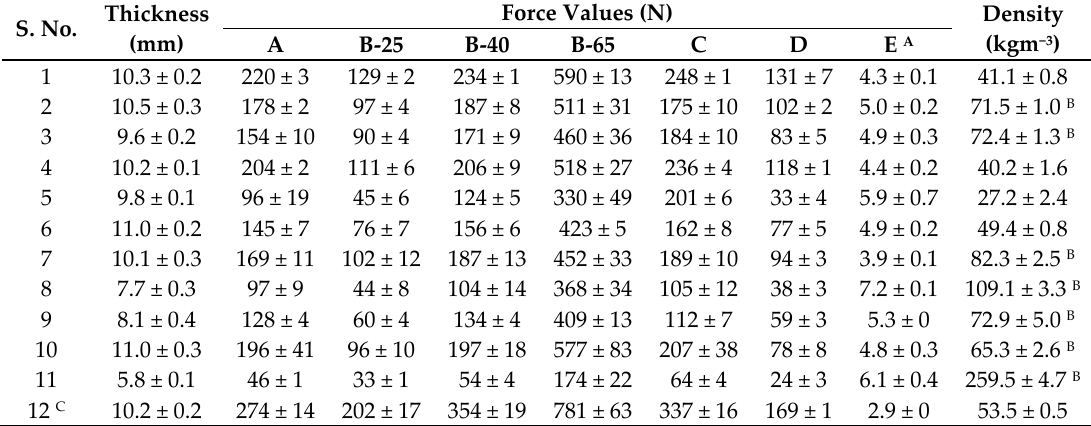
Table 1. Force measurements using the five different methods in ISO: 2439 and density. (mean ± SD). S.